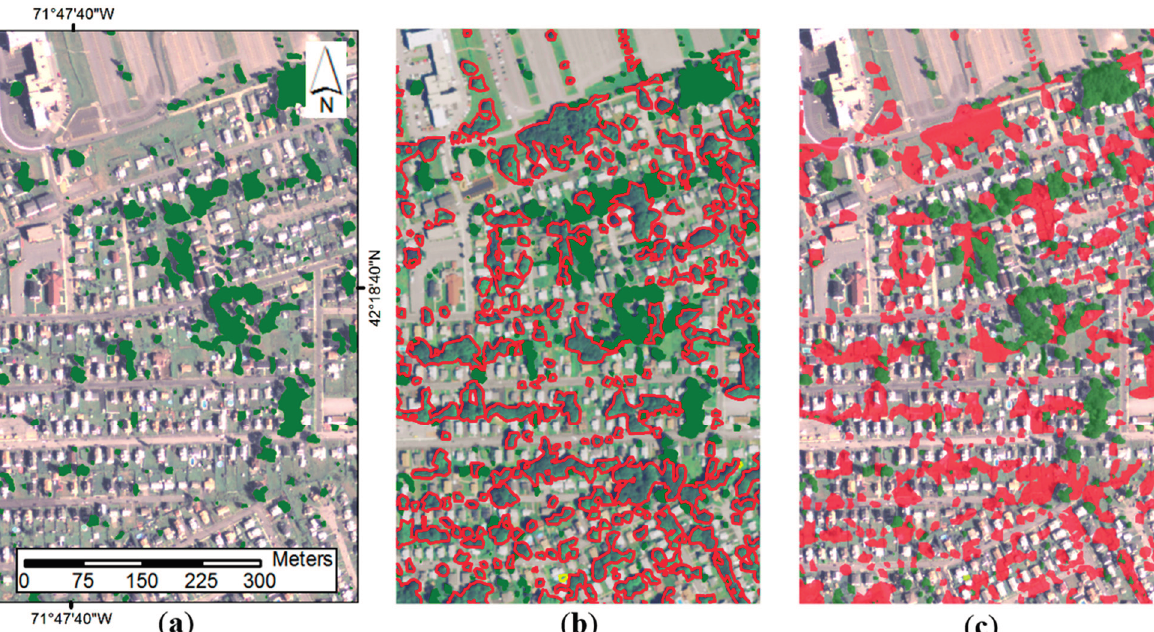
Figure 7. Retrospective change detection analysis for Worcester, Massachusetts, USA based on manual comparison of GEOBIA-produced high-resolution tree canopy map to earlier multispectral imagery. ( a ) 2010 Tree Canopy (green) superimposed on 1-m GSD 4-band NAIP imagery from which it was modeled. ( b ) Manual comparison of 2010 Tree Canopy to 1-m GSD 4-band NAIP imagery acquired in 2008, with drawn lines representing tree canopy lost during 2-year period (red) and tree canopy gained (yellow). ( c ) Final change-detection layer superimposed on 2010 NAIP, with No Change (green), Loss (red), and Gain (yellow)